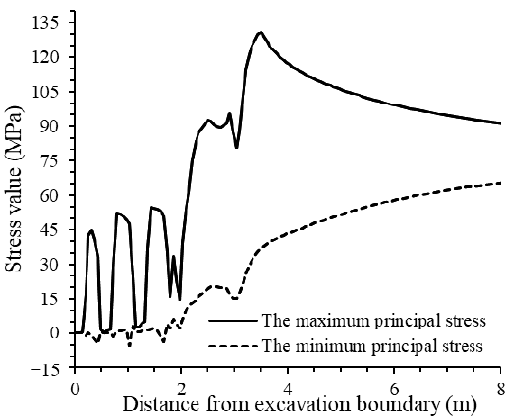
Figure 10. Stress state of surrounding rock along radial horizon.